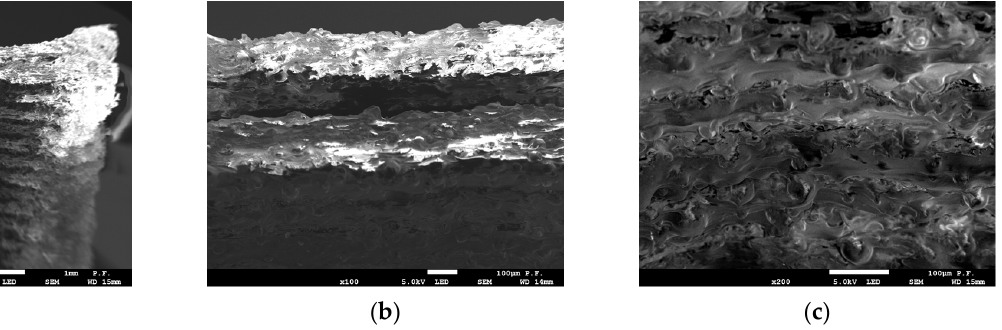
Figure 8. Cross-section of specimen 1.0 2Z composed of PLA + bronze after fracture observed with a scanning electron microscope. Observation direction—at an angle of 45° to the cross-section; ( a ) magnification ×25; ( b ) magnification ×100; ( c ) magnification ×200.